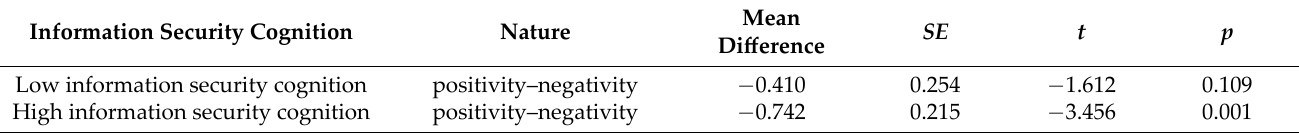
Table 8. Simple Effects (Information Security Cognition and Framework